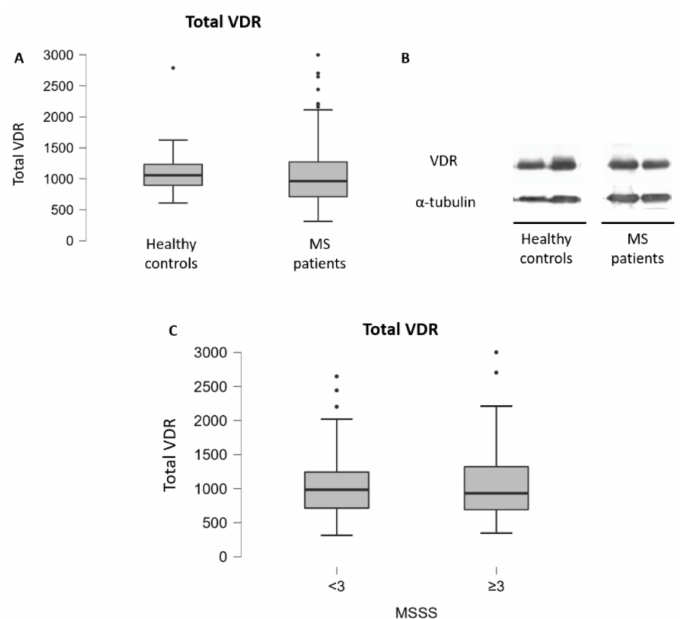
Figure 1. ( A ) Total VDR protein expression. MS patients and healthy controls; 25th percentile, median and 75th percentile are reported on the dot plot (black bars). No statistically significantly difference between MS patients and healthy controls was observed (Mann–Whitney test, p > 0.05). ( B ) Representative Western blot images of total VDR and α -tubulin protein content in PBMCs